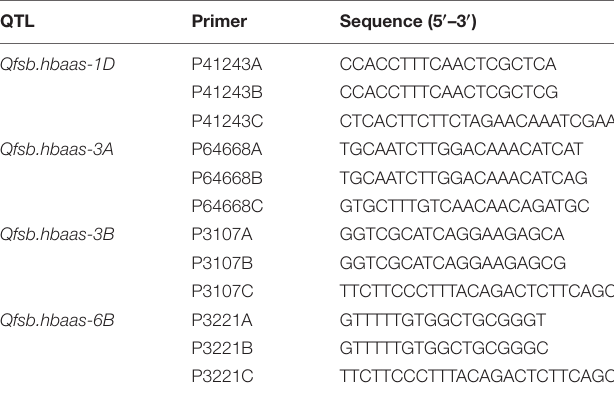
TABLE 4 | T- tests for differences in Fusarium seedling blight between two groups of wheat accessions with contrasting resistance or susceptibility alleles for quantitative trait loci (QTL) on chromosomes 1D, 3A, 3B, 6B, 7A, and Un. QTL